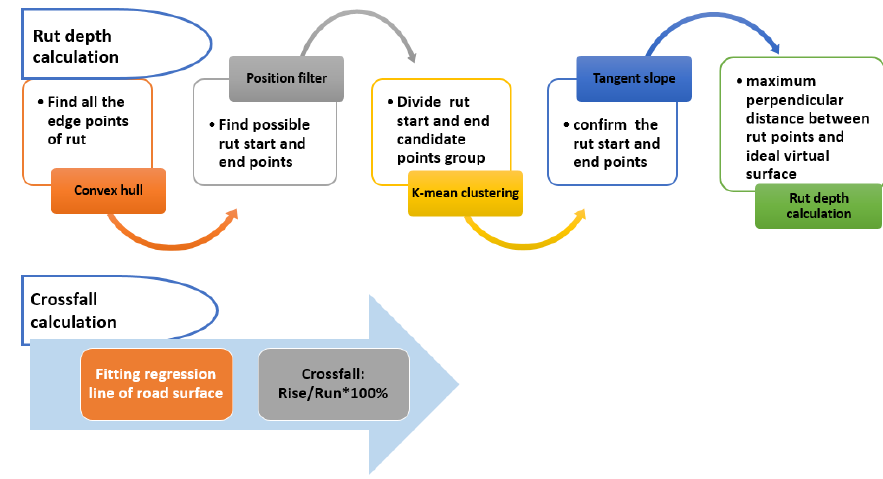
Figure 10. The process of rut depth and crossfall calculation.